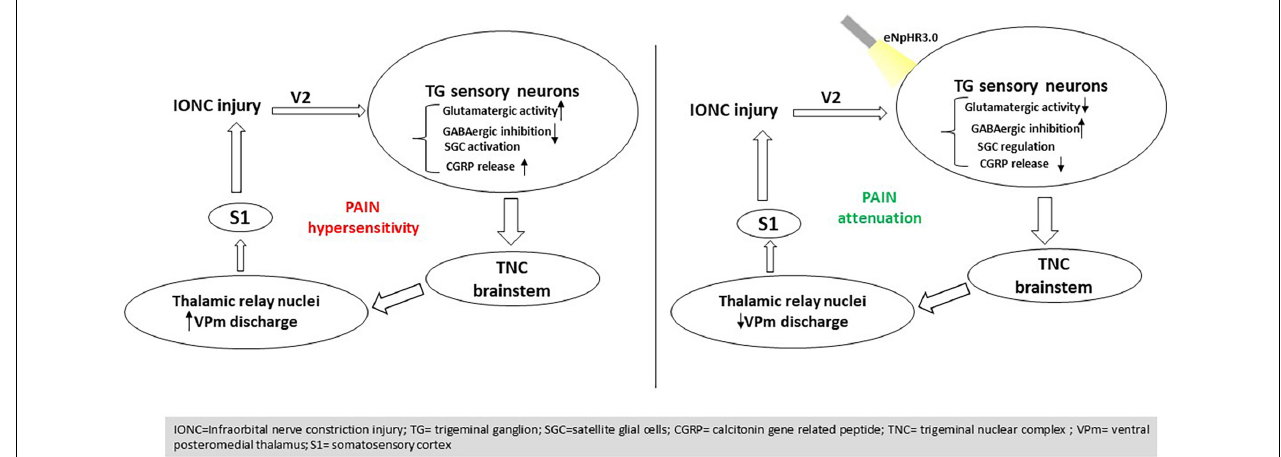
FIGURE 7 | Summary of the findings. Optogenetic inhibition in the trigeminal ganglion influences trigeminal brainstem and thalamic relay nuclei directing to the S1 cortex, resulting in pain mitigation induced by nerve injury.